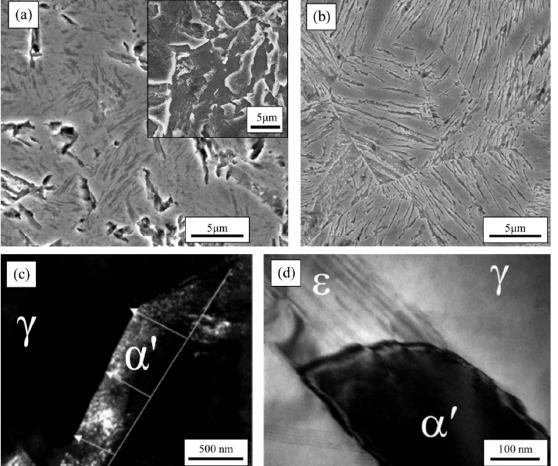
Figure 1. ( a ) Strain induced (granular) bainite formed at 520 ◦ C in a medium carbon high silicon steel surrounded by a martensite matrix, reprinted from [35], Copyright (2021) with permission from Elsevier; ( b ) strain induced (plate-like) bainite formed at 400 ◦ C in the same medium carbon high silicon steel surrounded by a martensite matrix, after [35]; ( c ) In-situ TEM micrograph taken during traction test showing the direct γ → α (cid:48) transformation observed while straining a 304 stainless steel at − 32 ◦ C, where the white arrows point the interface front and the straight white line is the invariant line; reprinted from [37], Copyright (2021) with permission from Elsevier; ( d ) in-situ TEM micrograph taken during traction test showing a α (cid:48) embryo on a band of ε in a 304L steel deformed at − 196 ◦ C, reprinted from [38], Copyright (2021) with permission from Taylor &